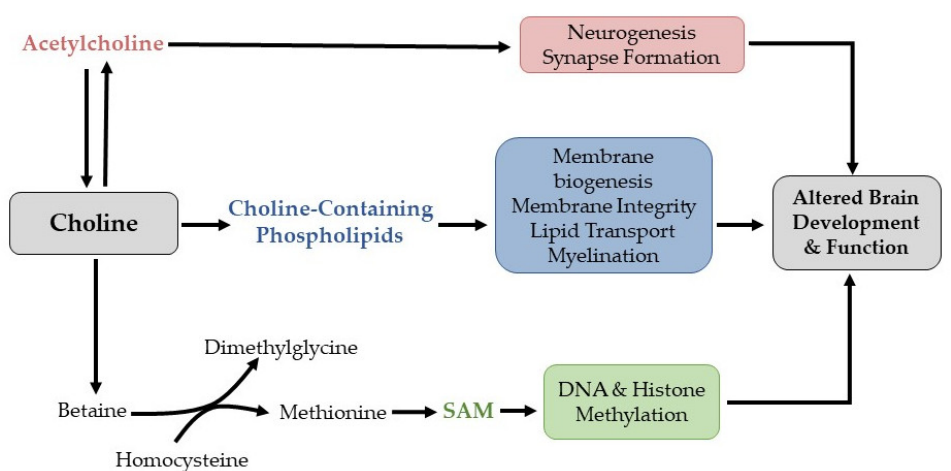
Figure 1. Choline serves as precursor for the following metabolites which impact brain development and function: (1) acetylcholine, a neurotransmitter that is involved in neurogenesis and synapse formation; (2) choline-containing phospholipids (e.g., phosphatidylcholine, sphingomyelin) which contribute to membrane biogenesis, lipid transport, and myelination; (3) betaine, which participates in one-carbon metabolism and aids in the regeneration of S-Adenosylmethionine (SAM). SAM is a methyl donor for both DNA and histone methylation.